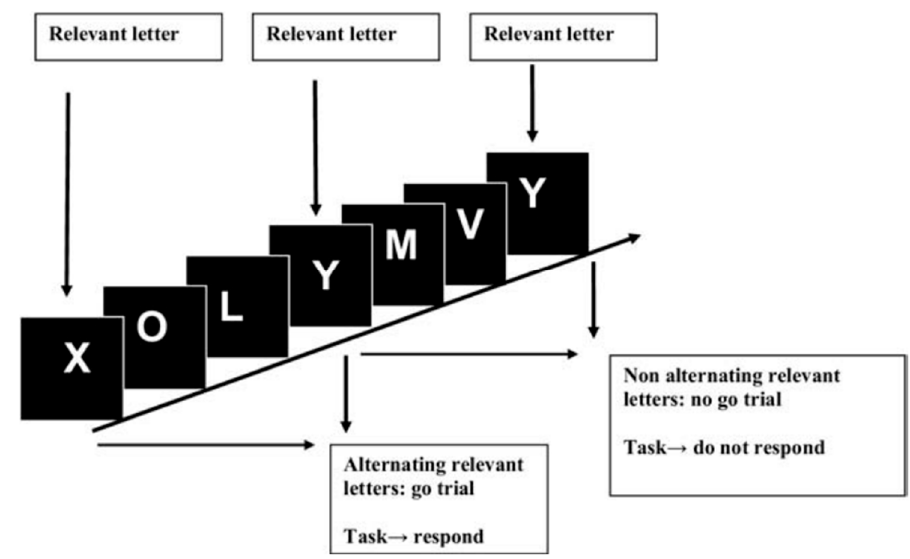
Figure 2. The inhibitory control test (ICT).